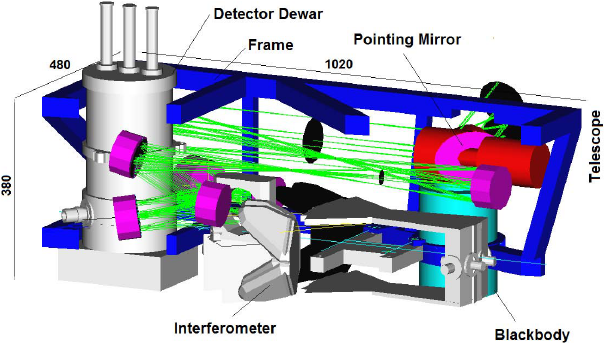
Fig. 1. Schematic representation of the optics module of MIPAS- STR (Blom et al., 1998). Mirrors are shown in pink and the light path along scan-mirror, telescope and interferometer towards the detector dewar is indicated by green lines. Dimensions indicated in mm.